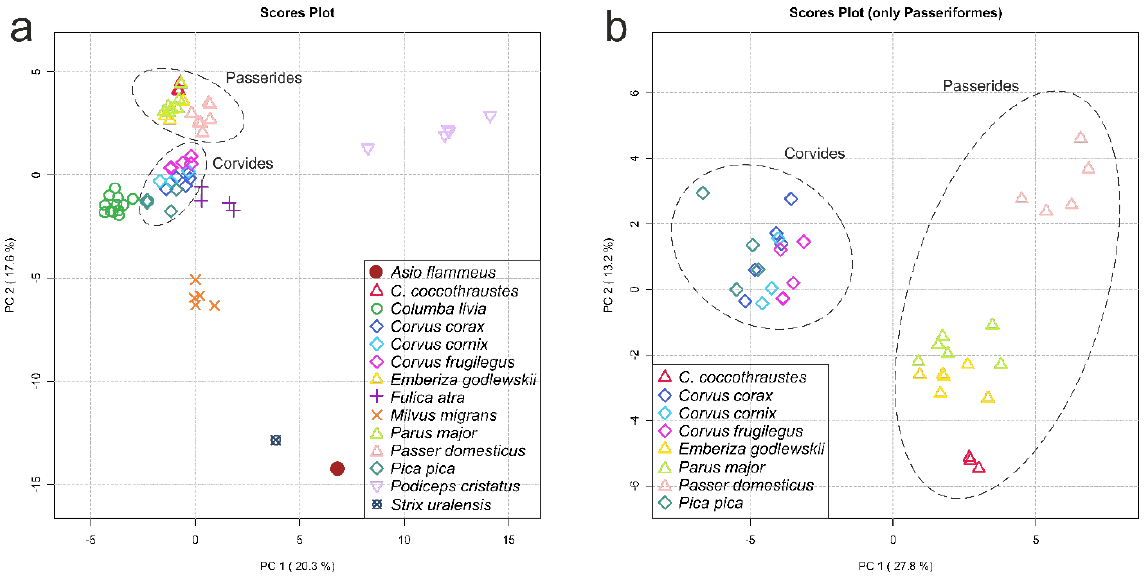
Figure 2. Scores plots of principal component analysis (PCA): ( a ) PCA based on the metabolomic profiles of eye lenses for 14 bird species; ( b ) the Passeriformes only. The data are auto-scaled. Dashed ovals indicate the Passerides and the Corvides infraorders. Variances explained by the first (PC1) and second (PC2) principal components are indicated on the axes of the scores